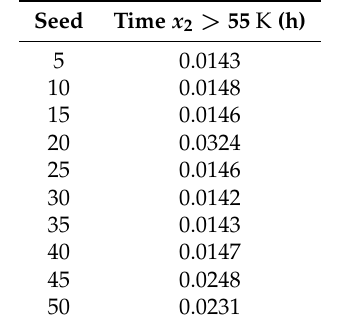
Figure 10. Scatter plot showing the control law chosen ( i in Table 3) in each sampling period by the randomized LMPC implementation strategy. Table 4. Approximate time after which x 2 > 55 K for various seed values of rng for the randomized LMPC design subjected to a cyberattack on the sensors determined in Section 5.2.1. Seed